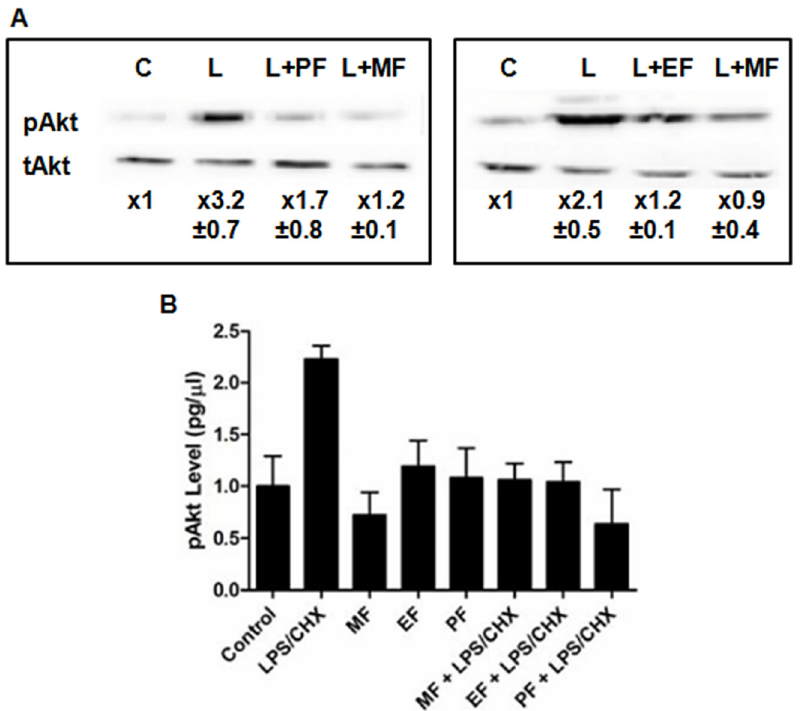
Figure 2. Inhibition of Akt phosphorylation by ALP compounds in HIV-1 vector-transduced or Tat expressing CHME5 cells. ( A ) CHME5 cells transduced with DHIV-GFP vector (D3) giving , 90% transduction and ( B ) Tat expressing CHME5 subline cells were exposed to LPS (50 m g/ml) and CHX (10 m g/ml) (‘‘L’’) in the presence and absence of 25 m M ALP compounds for 24 hours. For the transduced cells (A), the ratios between the levels of phospho-specific and total Akt proteins in the western blots were determined in triplicate, and these ratios were normalized by the ratio in the HIV-1 vector transduced control cells without any treatment (‘‘C’’). For the Tat expressing subline cells (B), the phospho-Akt levels were determined by ELISA-based assay, and the phospho-Akt level in the HIV-1 vector transduced control CHME5 cells with no treatment was used for signal normalization. L: LPS and CHX stress treatment, PF: perifosine, EF: edelfosine, MF: miltefosine.